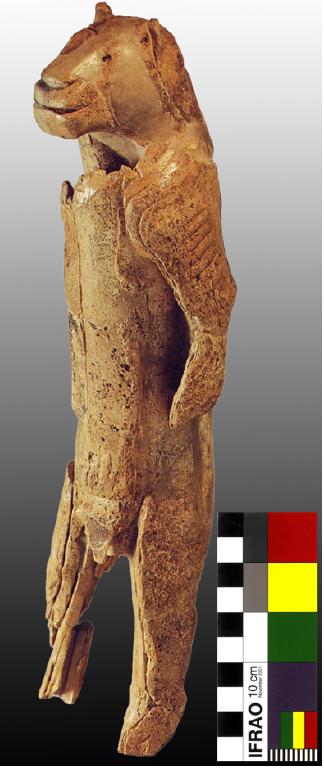
Figure 11. Ivory therianthrope, combining lion and human elements, 29.6 cm long and